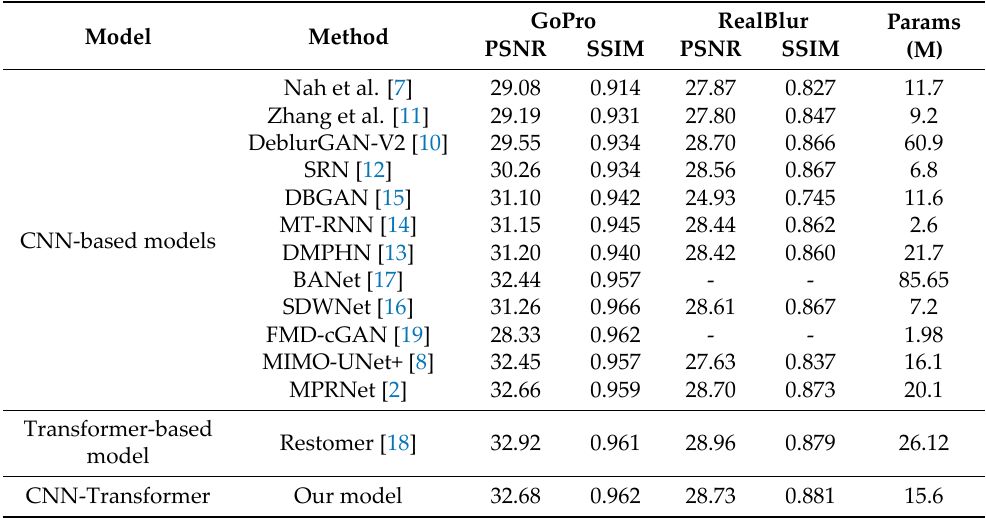
Table 1. Deblurring results of the advanced deblurring models, our model is trained on the GoPro [7] dataset and directly evaluates the RealBlur [31] test